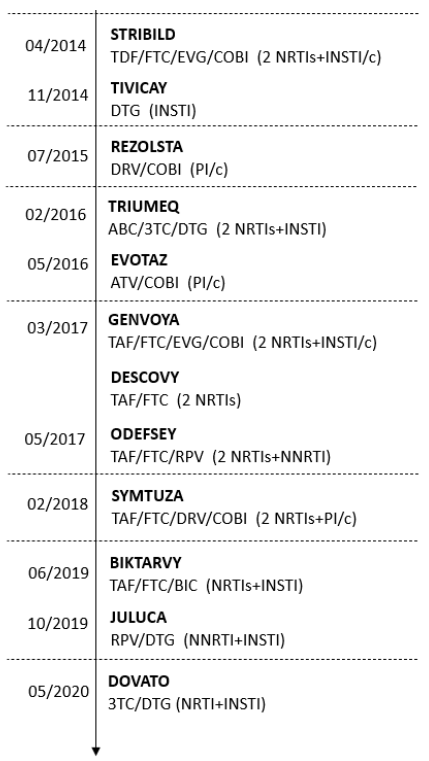
Figure 1. Timeline of the Italian Medicines Agency (AIFA) approval for antiretroviral medications during 2014–2020. Abbreviations: 3TC, lamivudine; ABC, abacavir; ATV, atazanavir; BIC, bictegravir; COBI, cobicistat (used as booster = /c), DRV, darunavir; DTG, dolutegravir; EVG, elvitegravir; FTC, emtricitabine; INSTI, integrase strand transfer inhibitor; NRTI, nucleos(t)ide reverse transcriptase inhibitors; NNRTI, non-nucleoside reverse transcriptase inhibitors; PI/c, protease inhibitor pharmacologically boosted with cobicistat; RPV, rilpivirine; TAF, tenofovir alafenamide; TDF, tenofovir disoproxil fumarate.